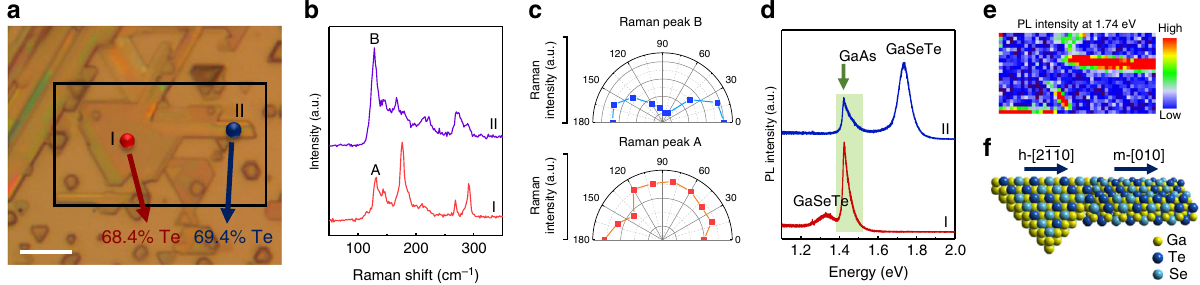
Fig. 4 Direct observation of phase transition. a Optical image of a GaSe 1 − x Te x fl ake with both hexagonal (region-I) and monoclinic (region-II) phase grown simultaneously. The composition for each region is indicated by Te% in the fi gure. Scale bar = 5 μ m. b Raman spectra taken at region-I and region-II from a. c Angle resolved Raman peak intensity of peak A and B from region-I and II. d PL spectra taken at region-I and II. GaAs substrate peak is labeled by green background. e PL mapping of the emission intensity at 1.74 eV taken from the area indicated by the rectangular in a . f Schematic of the 3D atomic structure of the coexisting hexagonal and monoclinic